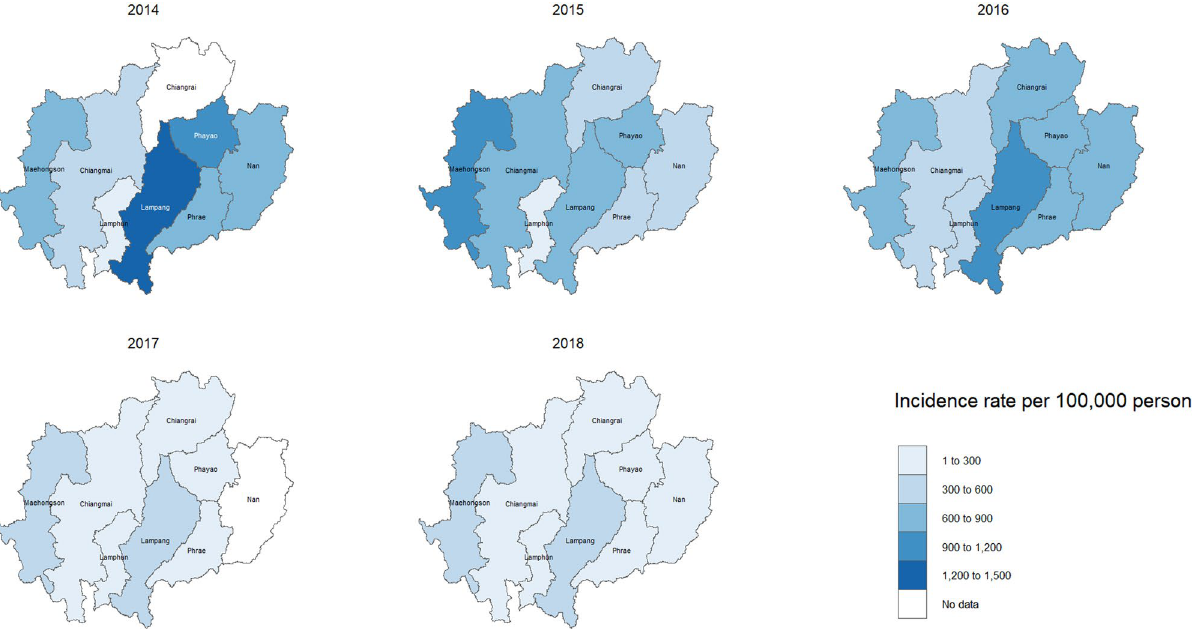
Figure 3. Incidence rates of annual total hospital visits for respiratory diseases attributable to fire-originated PM 10 for all ages during 2014–2018 by province. Map was generated using the package “ raster ” 46 and “ tmap ” 47 of R (version 4.1.3, The R Foundation for Statistical Computing, Vienna,